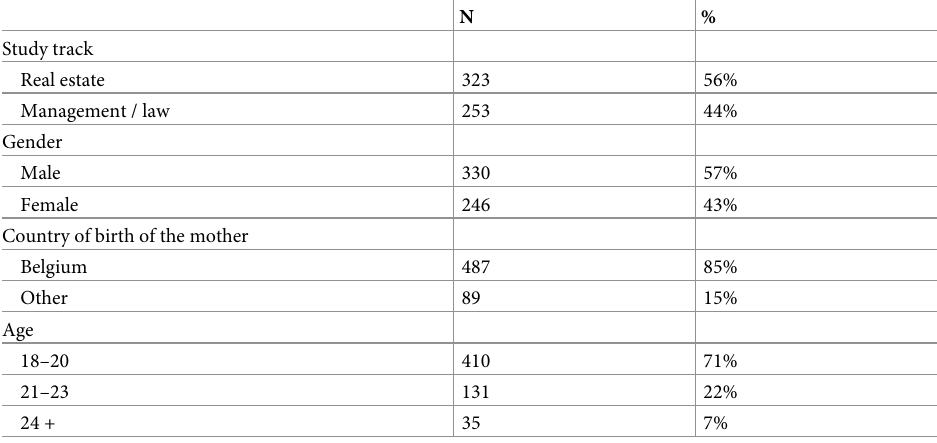
Table 1. Characteristics of the respondents in the vignette study (n =